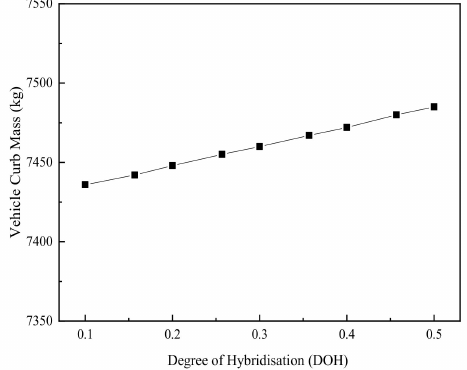
Figure 11. Figure caption curve of vehicle curb mass with degree of hybridization.